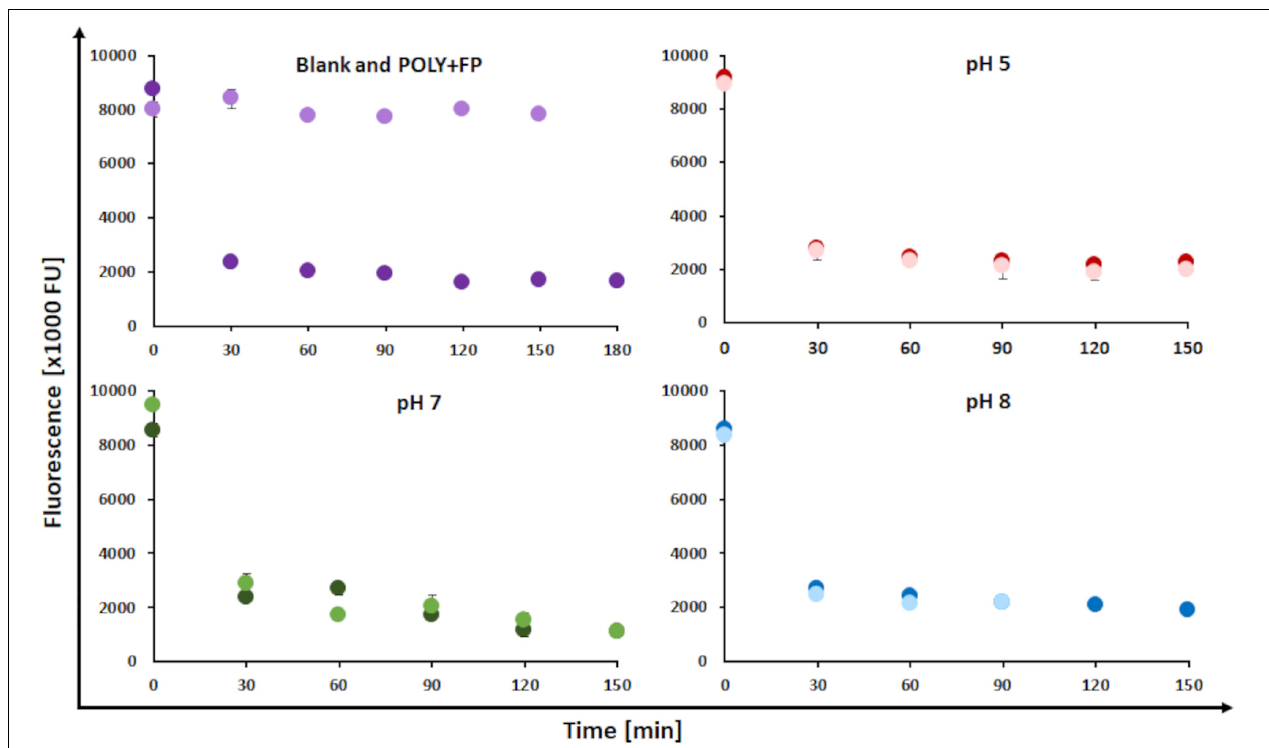
FIGURE 3 | Changes in fluorescence during laccase catalyzed coupling of FP onto LS at a temperature of 23 ◦ C, addition of 1% (w/v) FP and at different pH conditions. (Upper left) Blank sample (LS without enzyme, FP added after 30 min; light purple dots) and POLY + FP sample (LS + MtL, FP added in the end of the reaction after 150 min; dark purple dots). (Upper right) Control sample (LS + MtL, without FP added; dark red dots) and modified sample (LS + MtL, addition of FP after 30 min; light red dots) at pH 5. (Lower left) Control sample (darkt green dots) and modified sample (light green dots) at pH 7. (Lower right) Control sample (dark blue dots) and modified sample (light blue dots) at pH